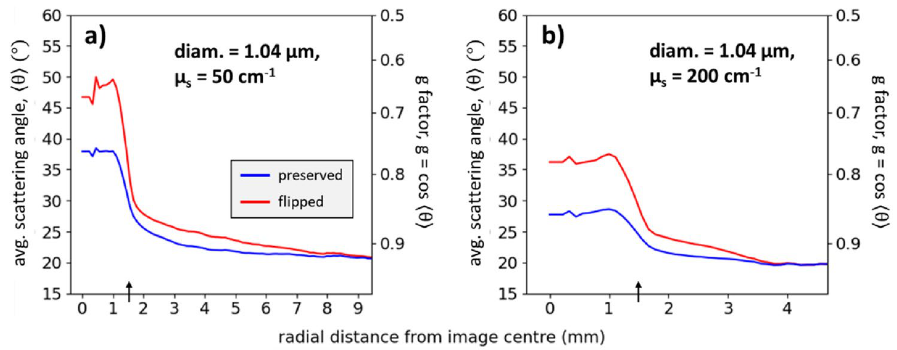
Figure 7. The average scattering angle for flipped and preserved photons as a function of radial distance for suspensions with 1.04 μm spheres at µ s = 200 cm -1 . The flipped profiles are higher than the preserved profiles due to the large angle scattering events of flipped